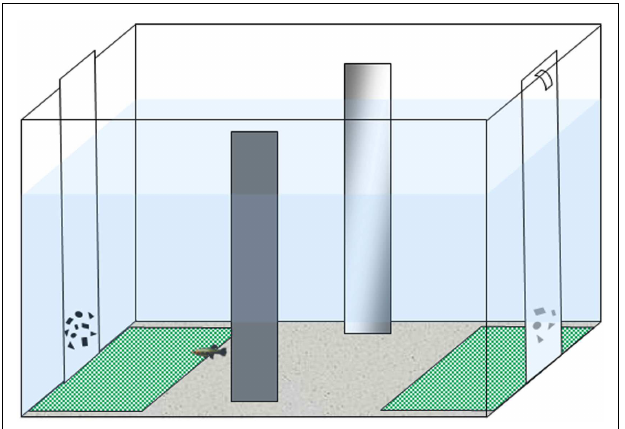
FIGURE 1 | Experimental apparatus. Subjects were housed in the experimental tank for the entire experiment. Stimuli (two groups of geometric figures differing in numerosity) were presented at the bottoms of the tank.